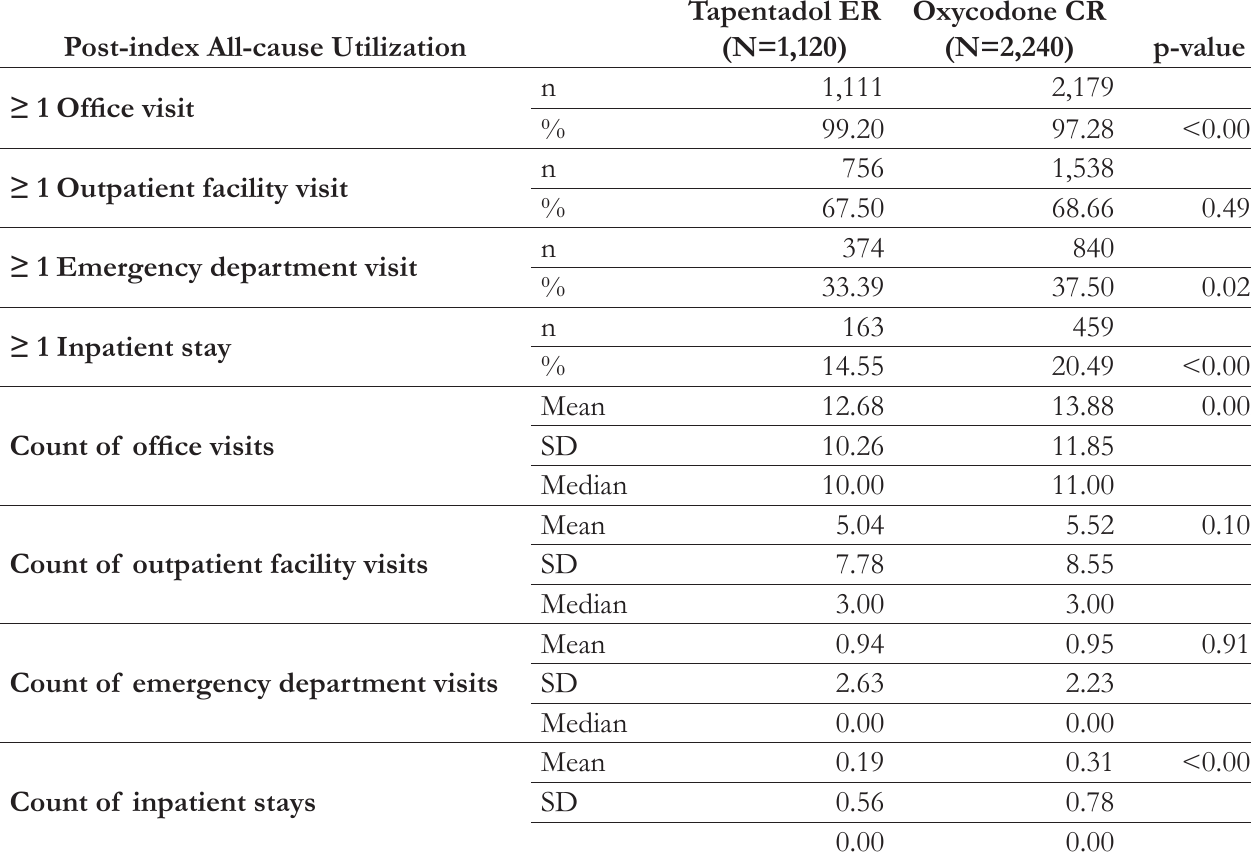
Table 3. Post-index Health Care